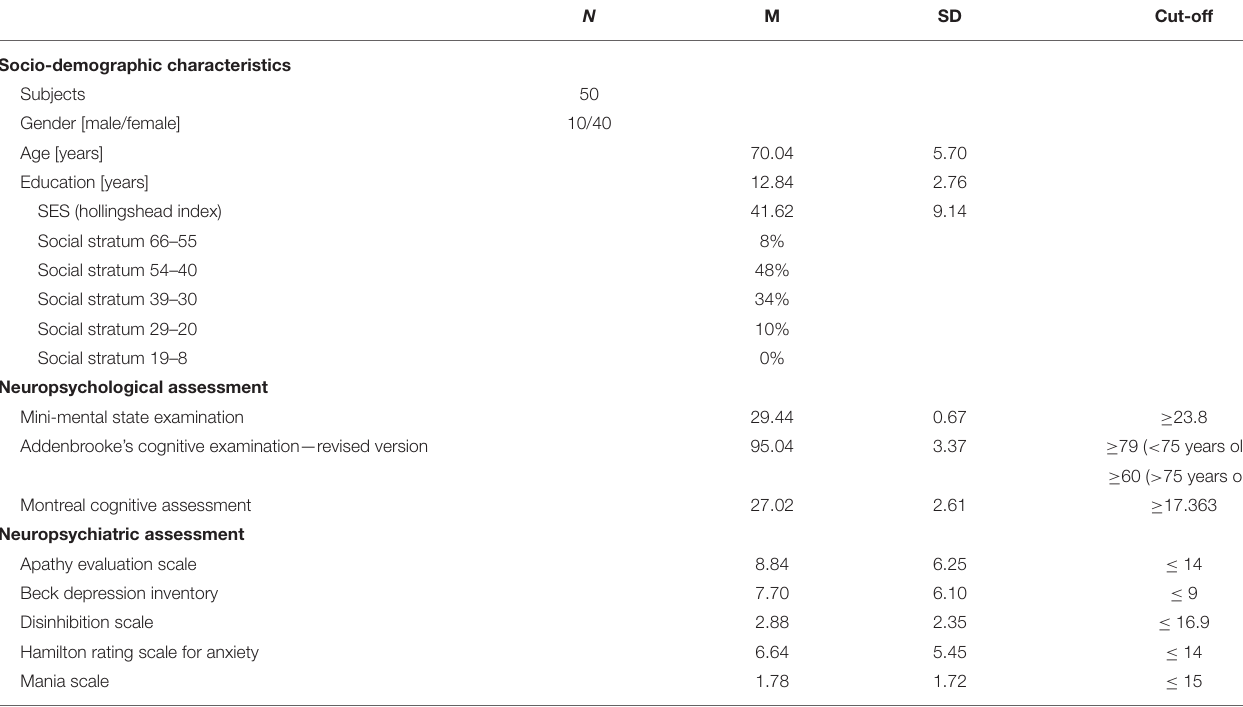
TABLE 4 | Follow-up: socio-demographic characteristics and neuropsychological assessment (T2). N M SD Cut-off